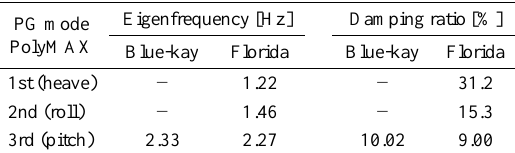
Active susp. equipped car: Comparison of the modal parameters estimated in different proving ground